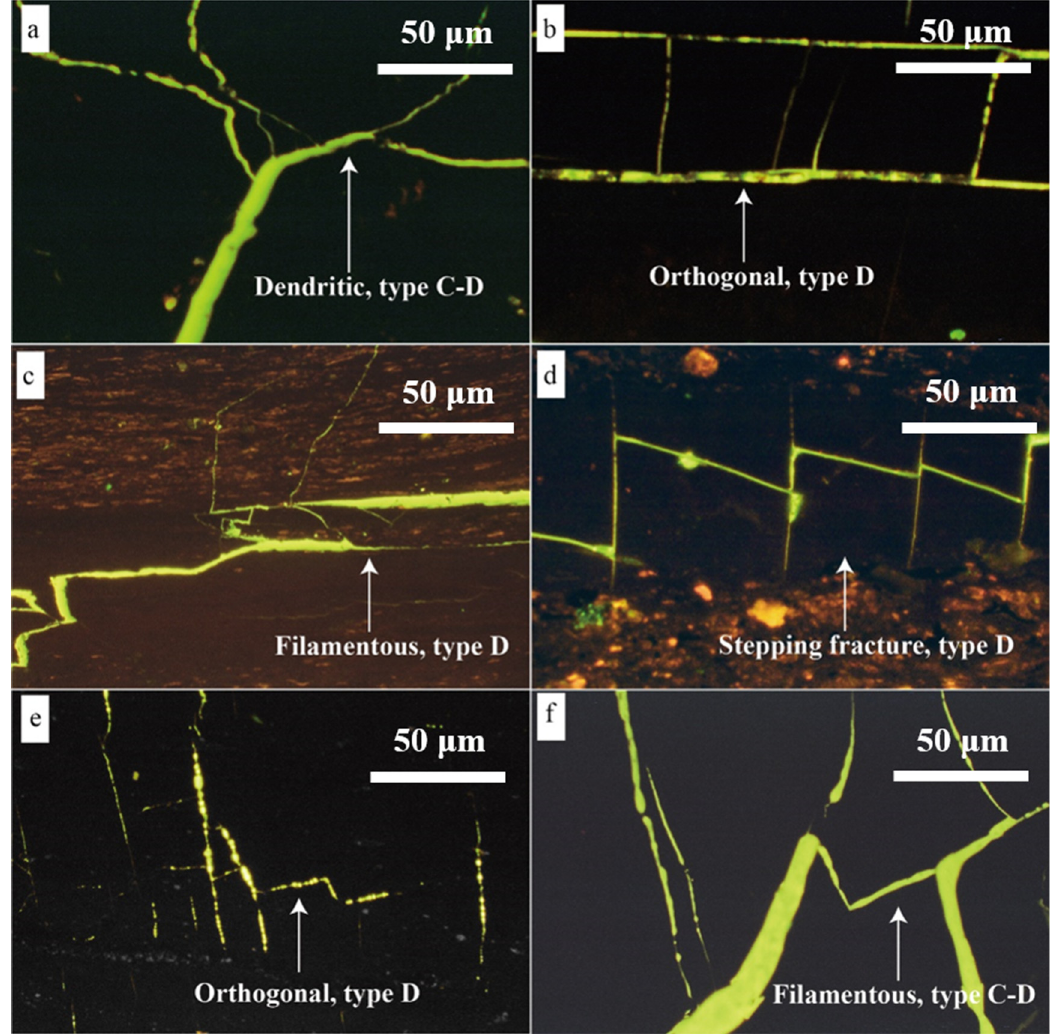
Figure 6. Morphology and frequency of endogenous microfractures observed by optical microscope (×63). ( a ) Sample NE19, Dendritic, F = 213; ( b ) Sample NE14, orthogonal, F = 67; ( c ) Sample NE22, filamentous, F = 25; (d) Sample NE4, orthogonal, F = 30; (c) Sample NE25, orthogonal, F = 137; ( d ) Sample NE31, filamentous, F = 61.